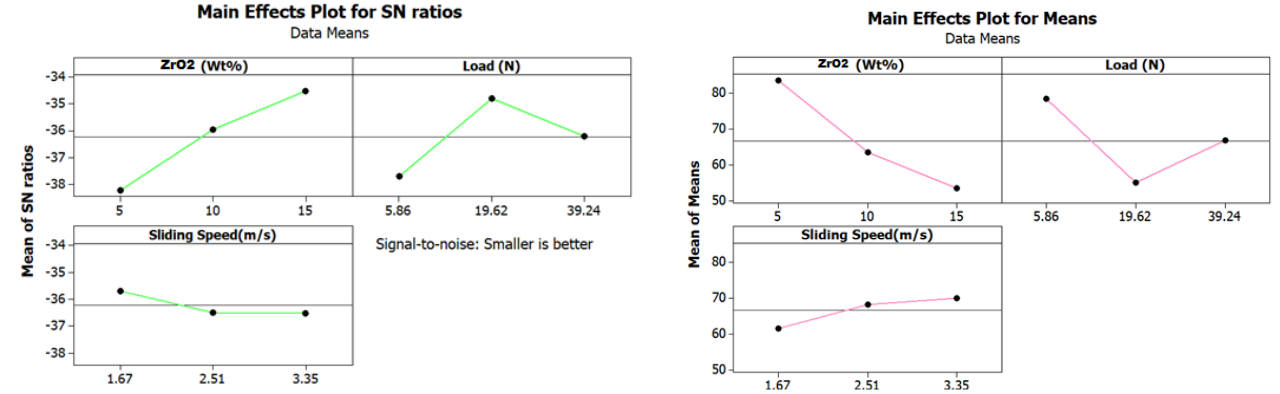
Figure 26. Mean S/N graph and mean of means for wear. Figure 26. Mean S / N graph and mean of means for wear.